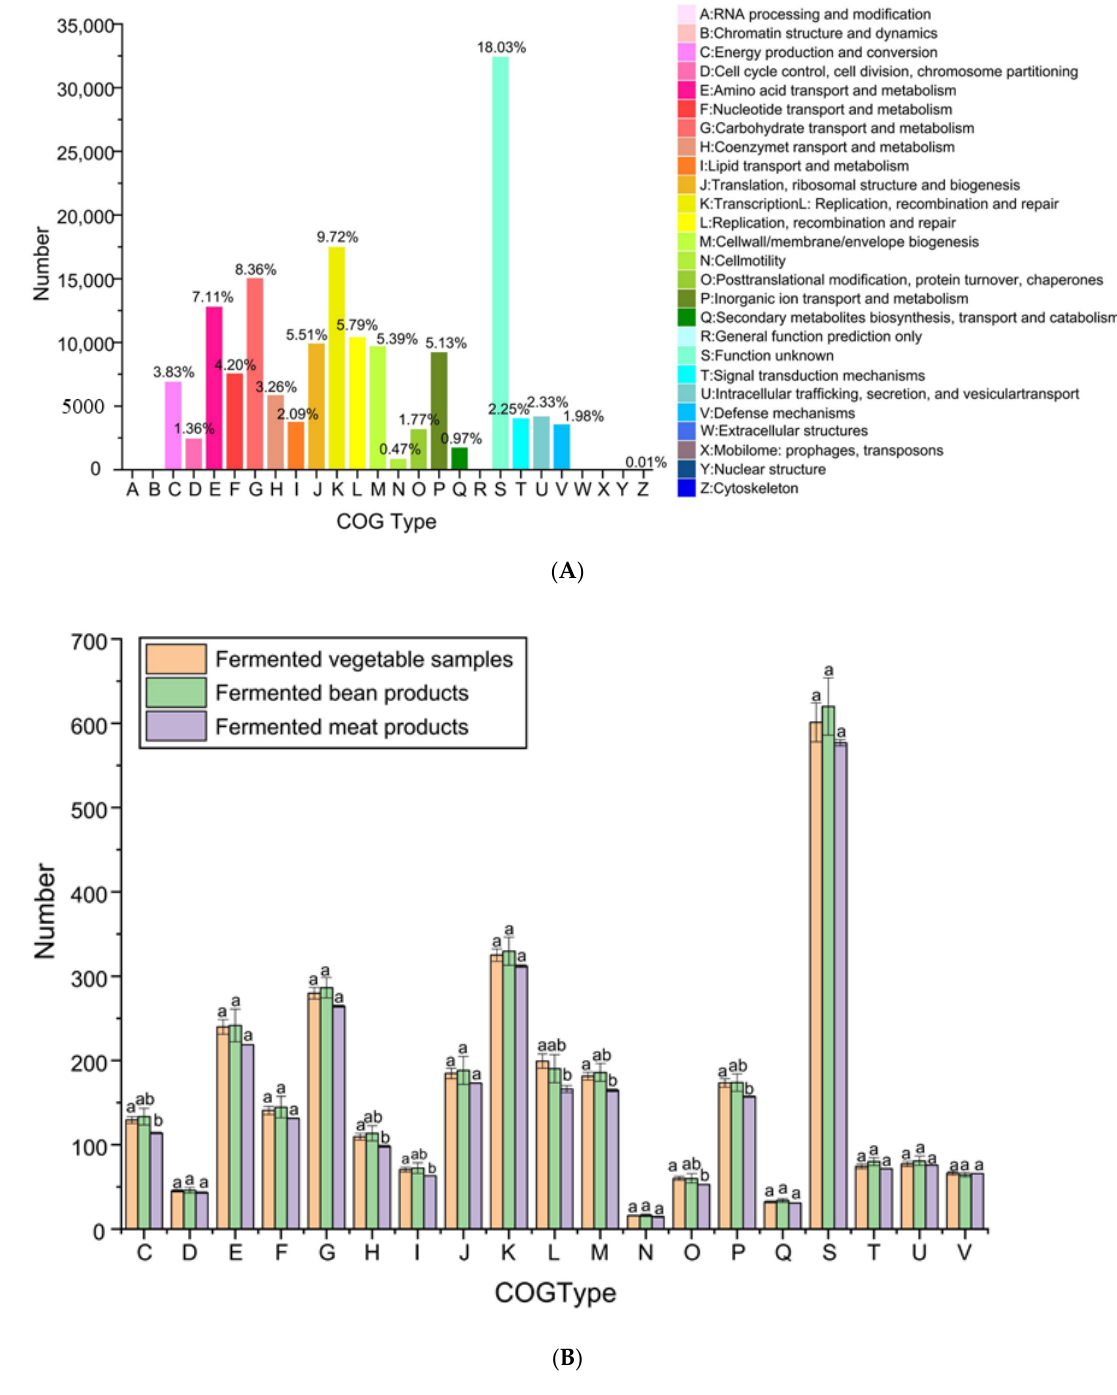
Figure 7. Analysis of COG functional annotation. ( A ) COG gene distribution in 54 strains of Lactobacillus plantarum ; ( B ) the number of COG gene distributions of L. plantarum isolated from different sources. Different lowercase letter means the significant difference ( p < 0.05); same lowercase letter means not significant difference ( p > 0.05).